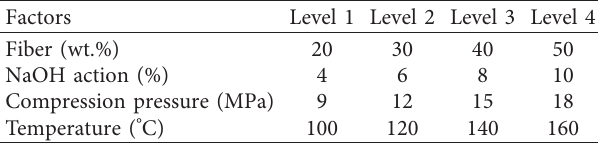
Table 1: Process parameters for fabrication of hybrid composites.